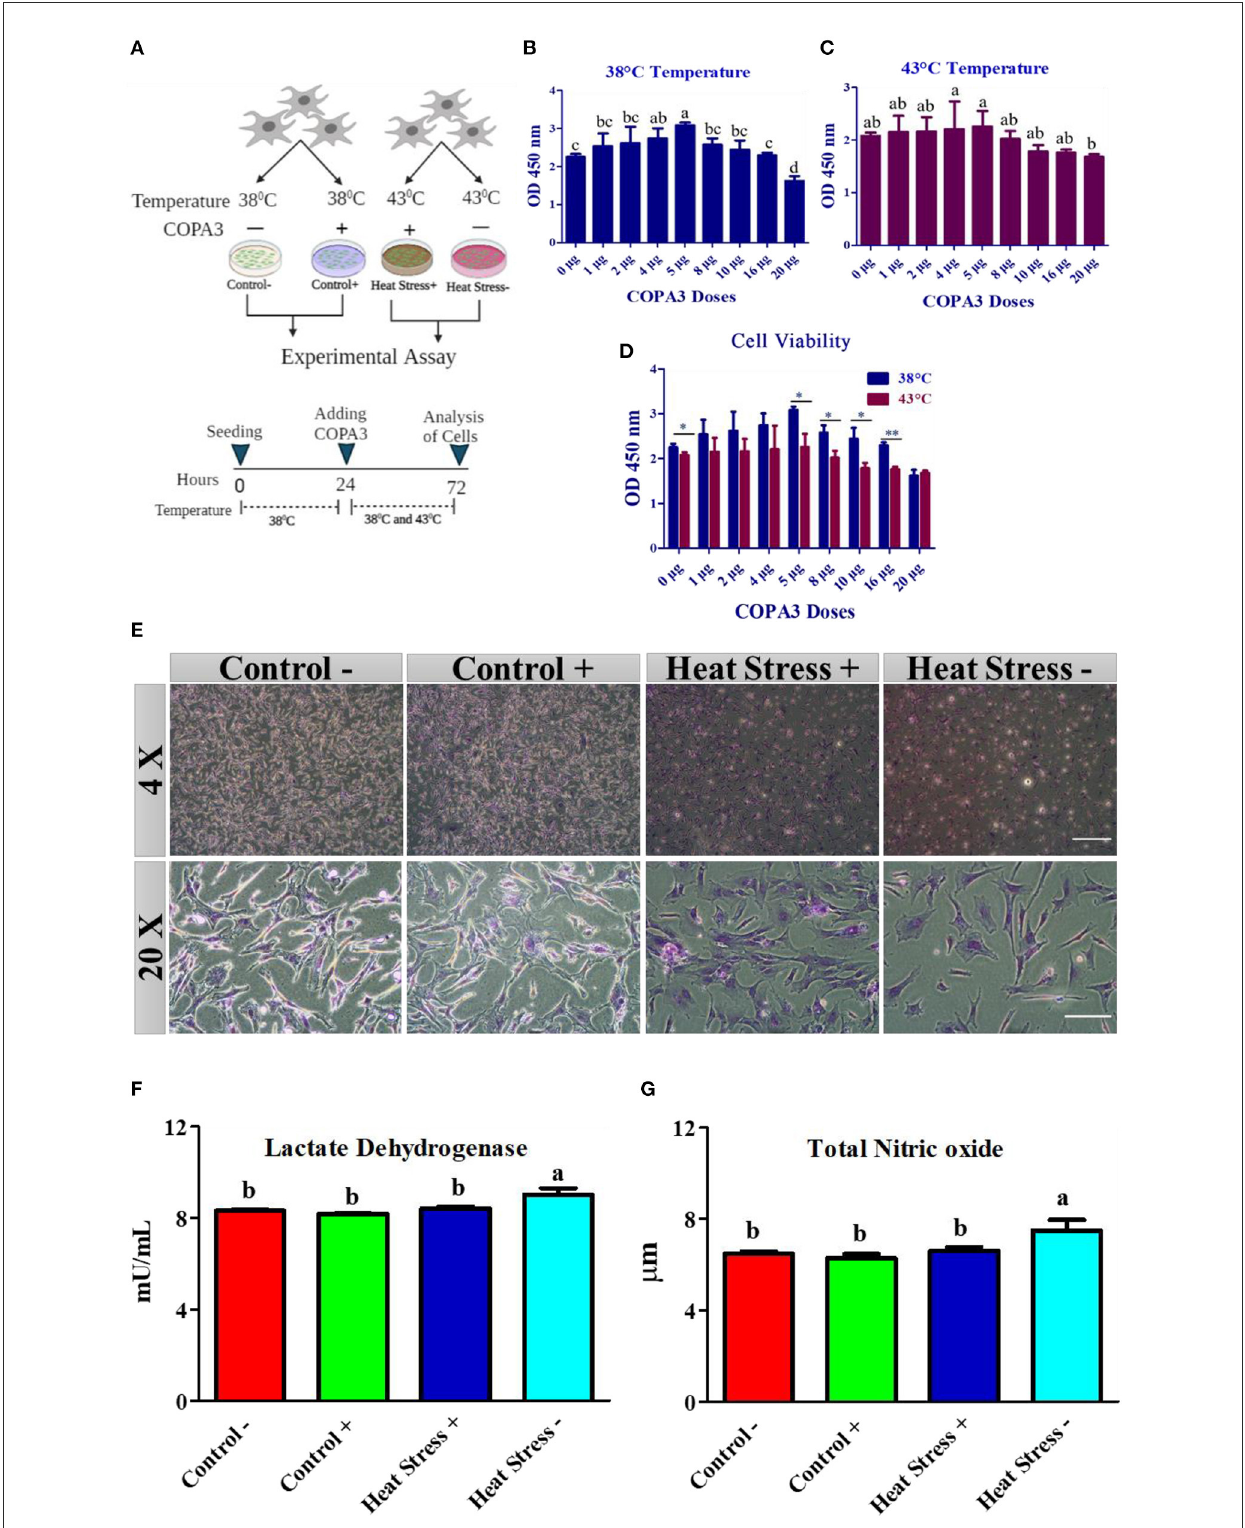
FIGURE1 COPA3 protects the stressed fibroblasts’ morphology by increasing heat tolerance. (A) Model experimental strategy; 38 ◦ C and 43 ◦ C temperatures indicate the control and the heat stress group, respectively; each group was subdivided into two groups based on COPA3 treatment. (B) Survival rates of fibroblasts at 38 ◦ C obtained using the CCK-8 assay; data represent mean ± SE; a − d different letters indicate significant difference in mean fibroblasts in 38 ◦ C ( P < 0.05). (C) Survival rate of fibroblasts at 43 ◦ C temperature obtained using the CCK-8 assay; data represent mean ± SE; a,b different letters indicate significant difference in the mean number of fibroblasts at 43 ◦ C ( P < 0.05). (D) Comparative survival rates of the fibroblasts at 38 ◦ C and 43 ◦ C obtained using the CCK-8 assay; data represent mean ± SE; * P < 0.05, and ** P < 0.001. (E) Giemsa staining showing